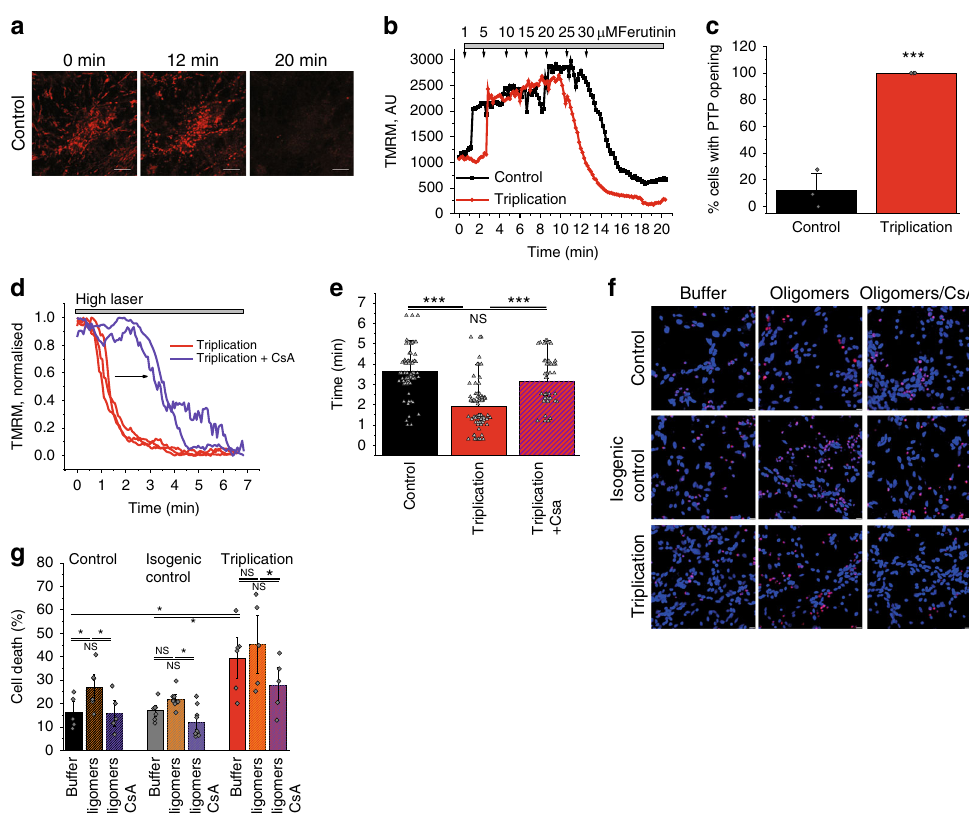
Fig. 6 Lowered PTP opening threshold and increased cell death in SNCA triplication iPS derived neurons. a Representative images of mitochondria labelled with TMRM before ferutinin was added (0 min), immediately before mPTP opening (12 min), and after mPTP opening (20 min). b Representative traces of PTP opening in control and triplications in response to ferutinin. c Proportion of cells (%) that fully opened PTP in response to 25 μ M ferutinin. N = 3 experiments, control n = 125 cells, and triplication n = 82 cells. d Representative traces of PTP opening in SNCA triplication neurons ± CsA in response to high laser. e Quanti fi cation of the time until laser-induced PTP opening in control ( N = 3 experiments; n = 77 areas), SNCA triplication neurons ( N = 3 experiments; n = 82 areas), and SNCA triplication neurons + CsA ( N = 3 experiments; n = 49 areas). f Representative images and g quanti fi cation of cell death in control, isogenic control, and triplication neurons challenged with control buffer or oligomers ± CsA. N = 3 experiments, n ≥ 763 cells. g Scatter points represent individual fi elds of view. Two-tailed Student ’ s t -test for c . One-way ANOVA with Bonferroni correction ( e , g ). Scatter points represent sampled fi elds of view. Data represented as mean ± SEM. Scale bar = 10 μ m. * p < 0.05; ** p < 0.01; *** p < 0.001